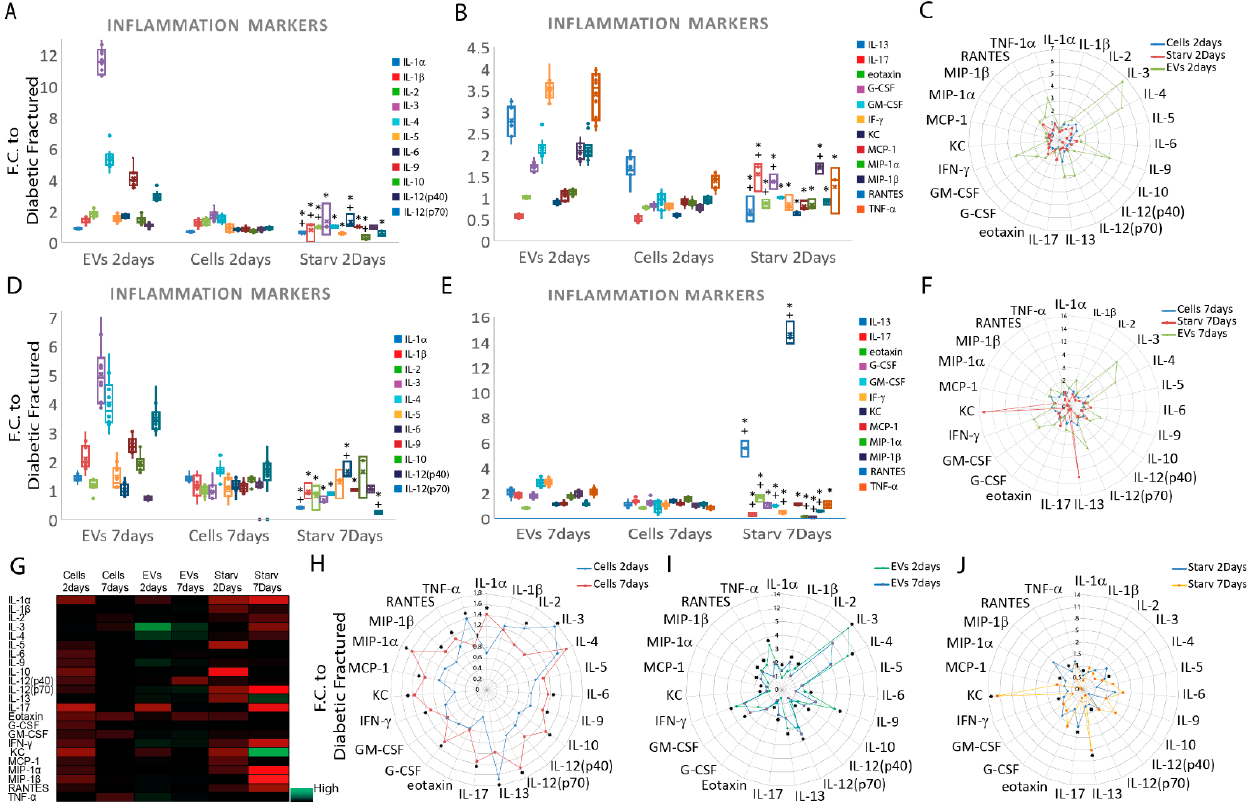
Figure 5. Comparison of inflammatory cytokine expression in diabetic mice treated with starved, regularly fed cells and EVs at two and seven days post fracture. ( A , B ) Graphs comparing the inflammatory cytokines in plasma at the day two time-point (sample size three to eight animals/group, one-way ANOVA followed by Tukey’s post hoc test). ( C ) Radar graph highlighting the differences between the different treatments at day two (sample size three to eight animals/group, paired t -test). ( D , E ) Graphs comparing the inflammatory cytokines at day seven (sample size three to eight animals/group, one-way ANOVA followed by Tukey’s post hoc test). ( F ) Radar graph highlighting the differences between the different treatments at the day seven time-point (sample size three to eight animals/group, paired t -test). ( G ) Heat map showing direct comparison of the inflammatory cytokines within the different treatments and the two time-points. ( H – J ) Radar graph highlights the differences between animals treated with cells ( H ), EVs ( I ), starved cells ( J ) at the different time-points. The data are normalized to fractured diabetic animals who had only PBS injection and presented as mean fold change ± SD. p ≤ 0.05 * respect EVs, + cells. Abbreviations: regularly fed cells (cells); starved cells (starved); extracellular vesicles (EVs); fold change (F.C.); interleukin (IL-1 α , 1 β , 2, 3, 4, 5, 6, 9, 10, 12(p40), 12(p70), 13, 17); granulocyte colony-stimulating factor (G-CSF); granulocyte-macrophage colony-stimulating factor (GM-CSF); interferon- γ (IFN- γ ); keratinocytes-derived chemokine (KC); monocyte chemotactic protein 1 (MCP-1); macrophage inflammatory protein-1 α , 1 β (MIP-1 α and MIP-1 β ); regulated on activation, normal T cell expressed and secreted (RANTES); tumor necrosis factor- α (TNF- α ).